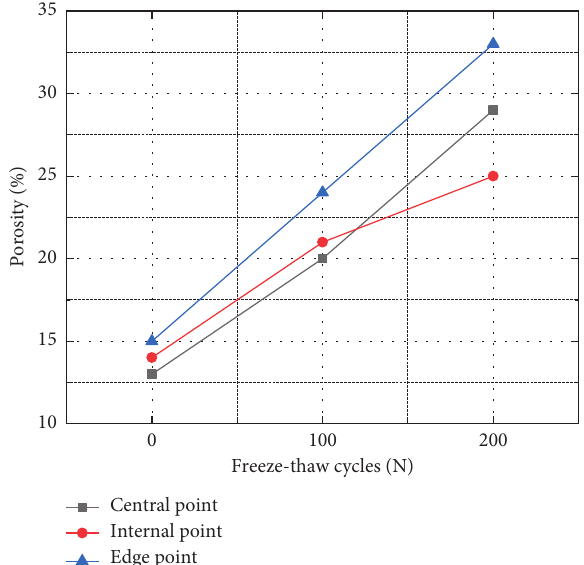
Figure 10: The effect of freeze-thaw cycles on the porosity of 12% theoretical corrosion ratio specimens.